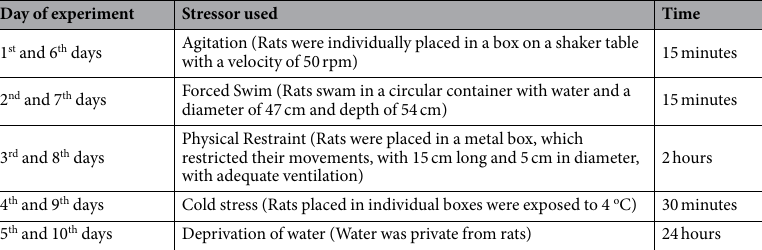
Table 1. 10-day representative schedule of stressor agents used during the